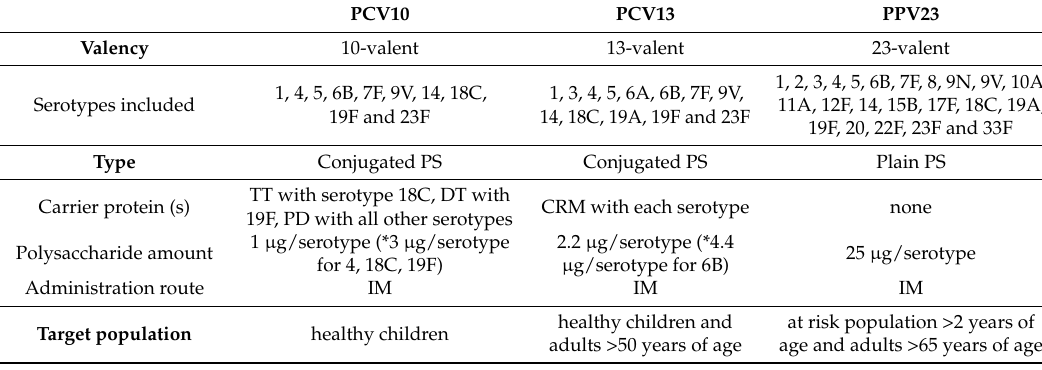
Table 1. Formulation differences between licensed pneumococcal vaccines currently in use. PCV10 PCV13 PPV23